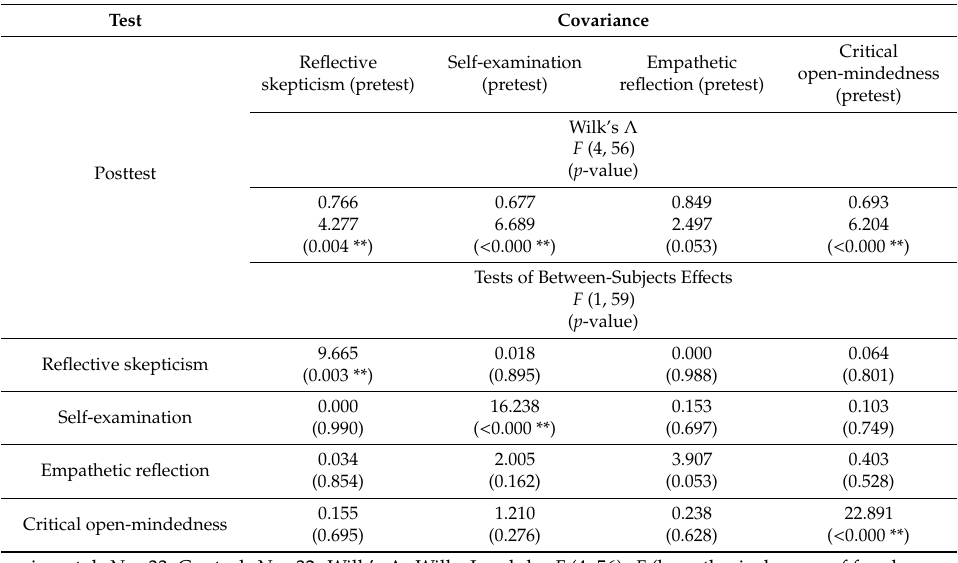
Table 3. Multivariate Analysis of Covariance (MANCOVA) results for the Reflective Thinking Scale for Healthcare Students and Providers